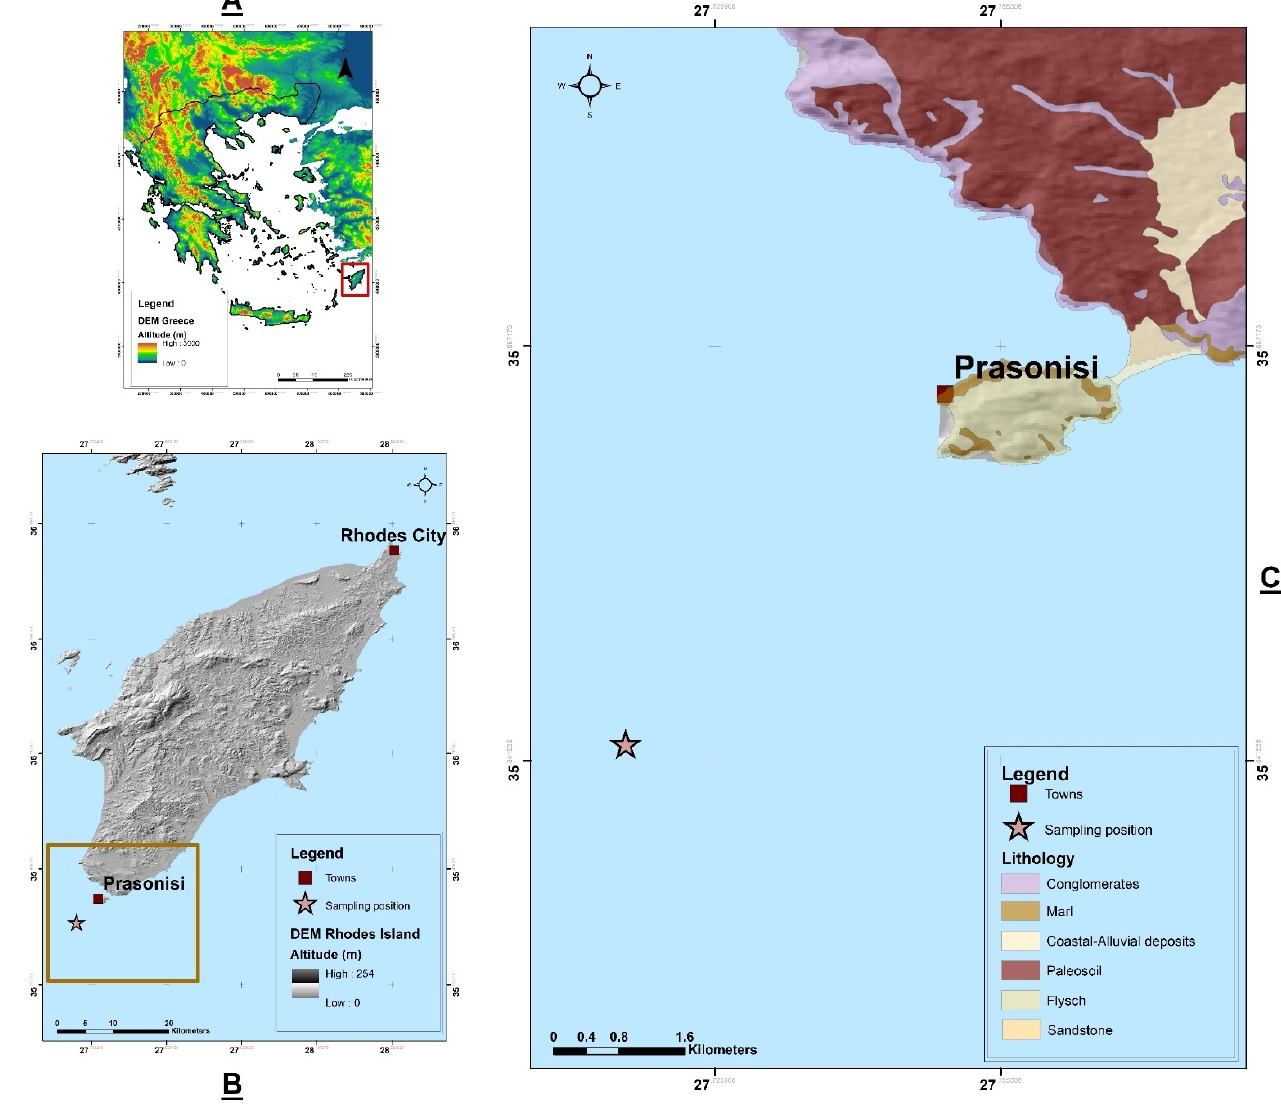
Figure 1. Location map: ( A ) location of Rhodes Island in Greece, ( B ) location of the study area in Rhodes Island, ( C ) detailed geographic information of the study area, along with the sampling position. Topographic data gathered from National Cadastre and lithological formations extracted from the geological map of Rhodes, Sheet “Rhodes” [25]. Figure created in Arcmap 10.7.1. The surface area of the Prasonisi Islet is about 1.5 km 2 , having a maximum length and width of 2 km and 1.3 km, respectively. It consists of Plio–Pleistocene limestones and its coast is abrupt and rocky. The southernmost coast of Rhodes Island consists of Pleistocene calcareous and Pliocene clastic (conglomerates) formations drained by small ephemeral streams (Figure